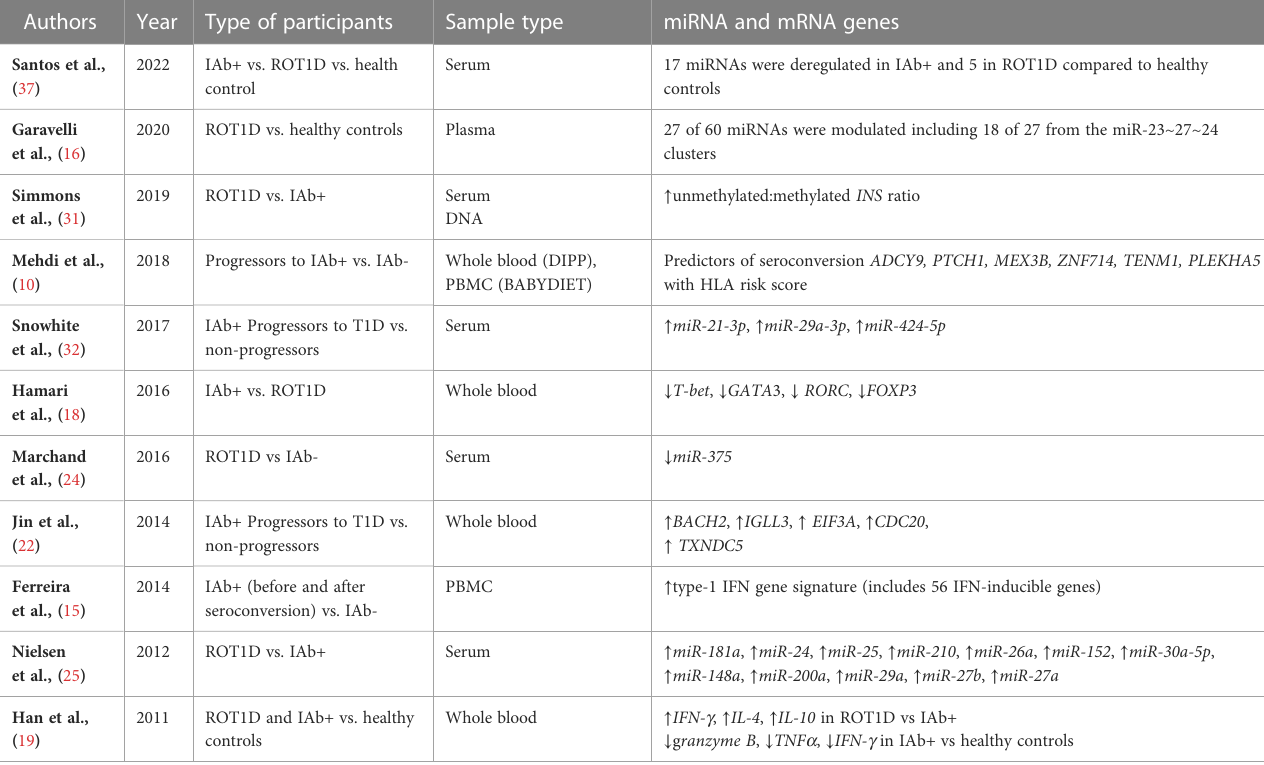
TABLE 4 Gene expression markers linked to T1D